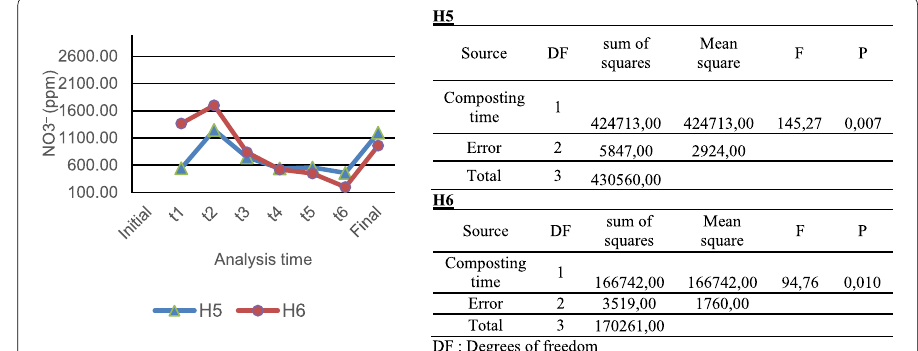
Fig. 4 NO3 – evolution during co‑composting of TM and OP (left) and ANOVA test associated (right). Initial values not